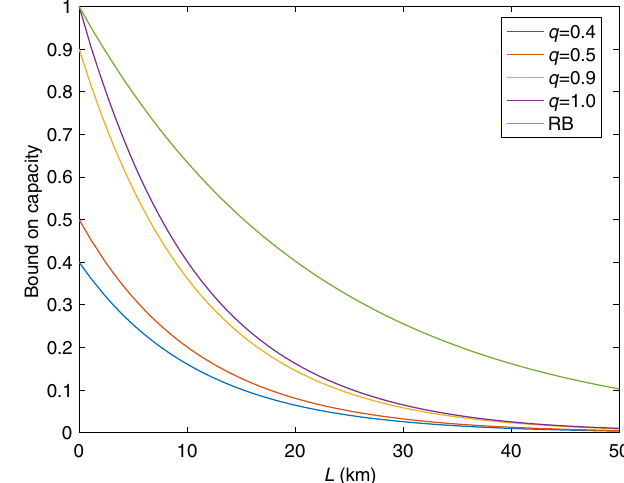
FIG. 5. Rate-distance trade-off comparison between our bound (64) (blue, red, yellow, and purple lines) and the RB bound (green line) for the MDI-QKD protocol for our photon-based